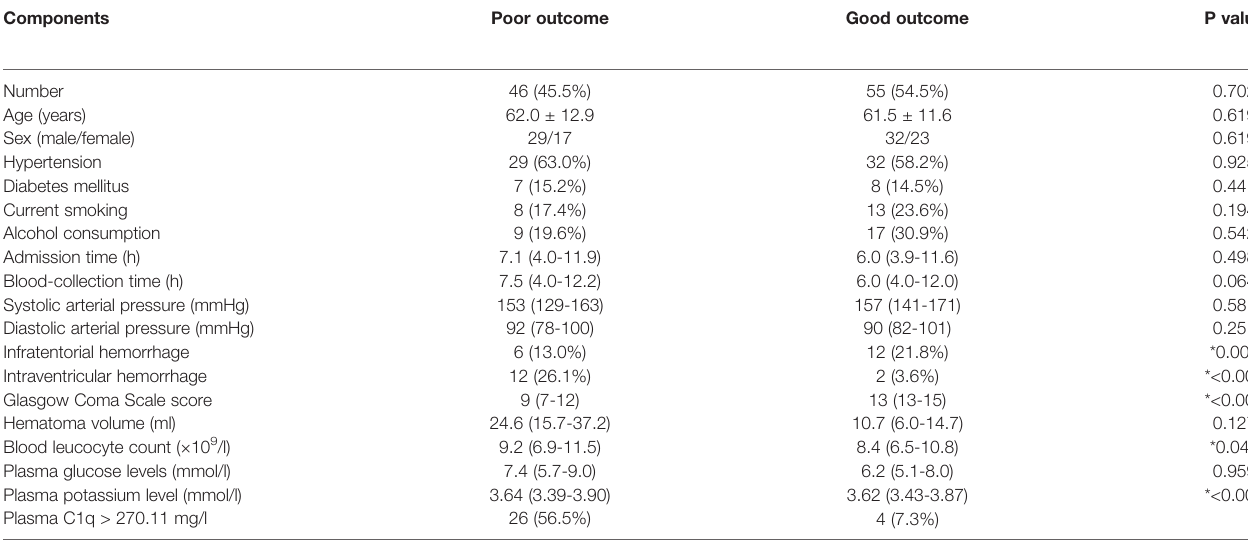
TABLE 4 | Demographic, Clinical, Radiological and Biochemical Factors for 3-month Poor Outcome After Acute Intracerebral Hemorrhage. Components Poor outcome Good outcome P value